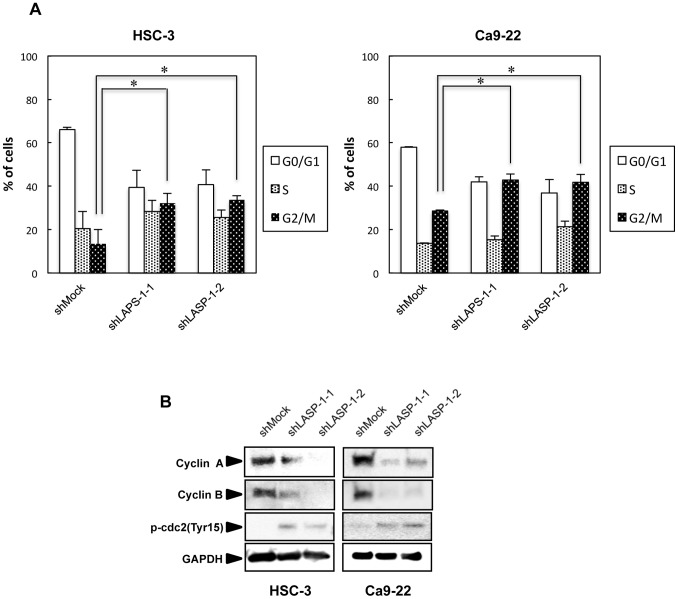
shLASP-1 promotes G2 arrest.(A) Flow cytometric determination of DNA content was analyzed using the Accuri C6 Flow Cytometer. shLASP-1-transfected HSC-3 and Ca9-22 cells show significant (*P<0.025; Mann-Whitney U test with Bonferroni correction) G2 phase accumulation as opposed to the shMock-transfected cells. (B) Immunoblotting analysis shows down-regulation of cyclin A and cyclin B and up-regulation of phospho-cdc2 in the knockdown cells.